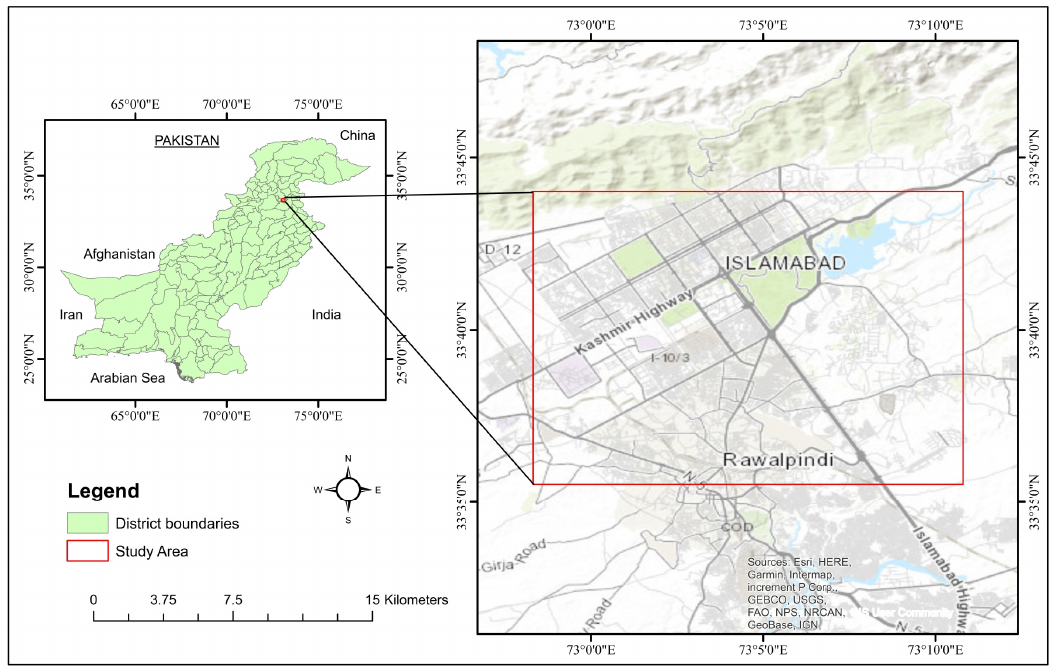
Figure 1. The geographical setting of the examined area.